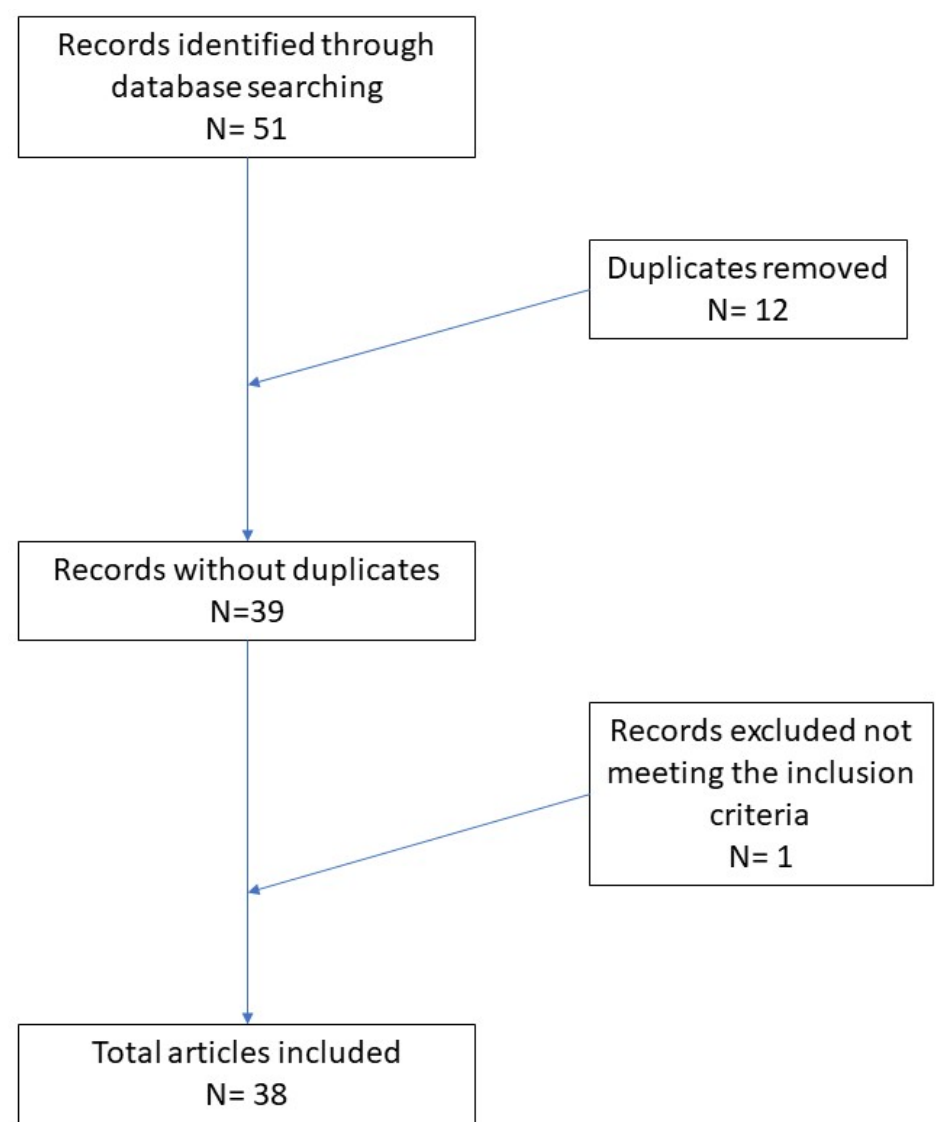
Figure 1. Literature search and article selection.